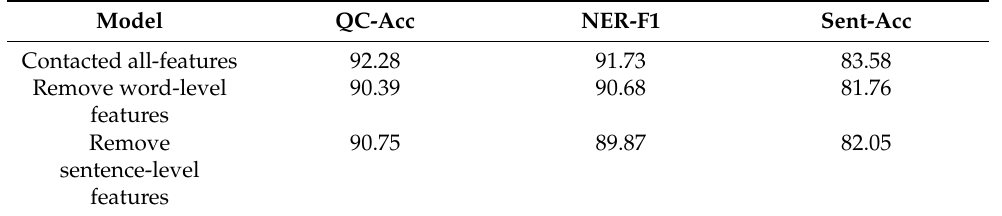
Table 6. Performance with different